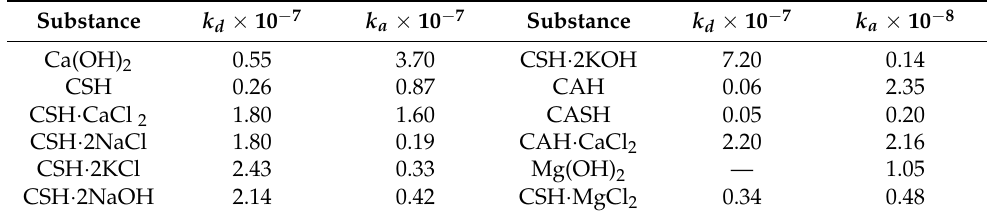
Table 1. The reaction constants of the major